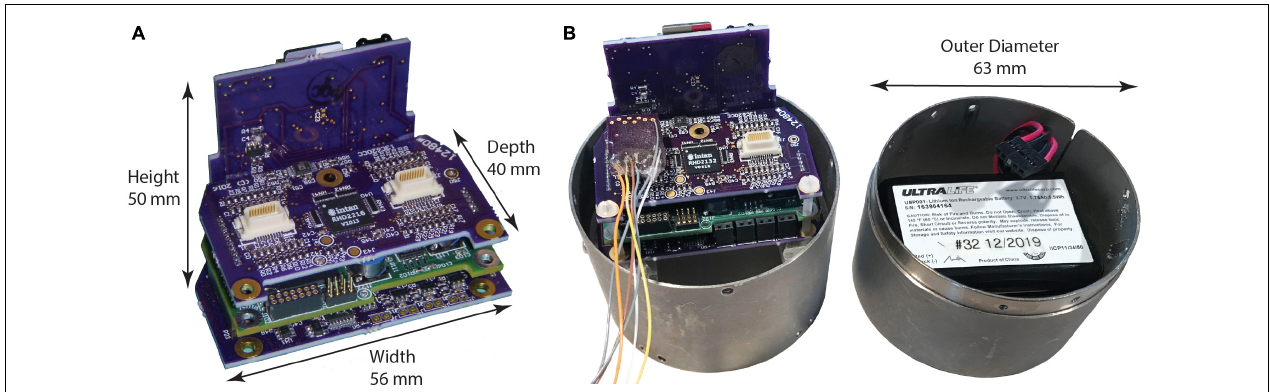
FIGURE 1 | Neurochip3 boards. (A) Assembled boards, from top to bottom: input connections and amplifiers chip, MCU and FPGA, and stimulator control; back plane contains power supply, SD Card, IR communications port, and indicator LEDs. (B) NC3 with cylinder enclosure, signal input connector, and battery pack in